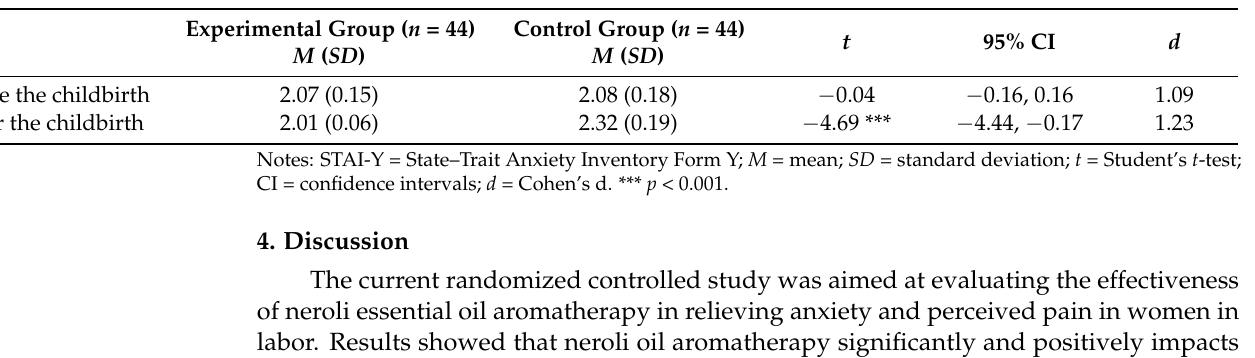
Table 4. Comparisons between experimental and control groups on anxiety measured with STAI-Y before and after the